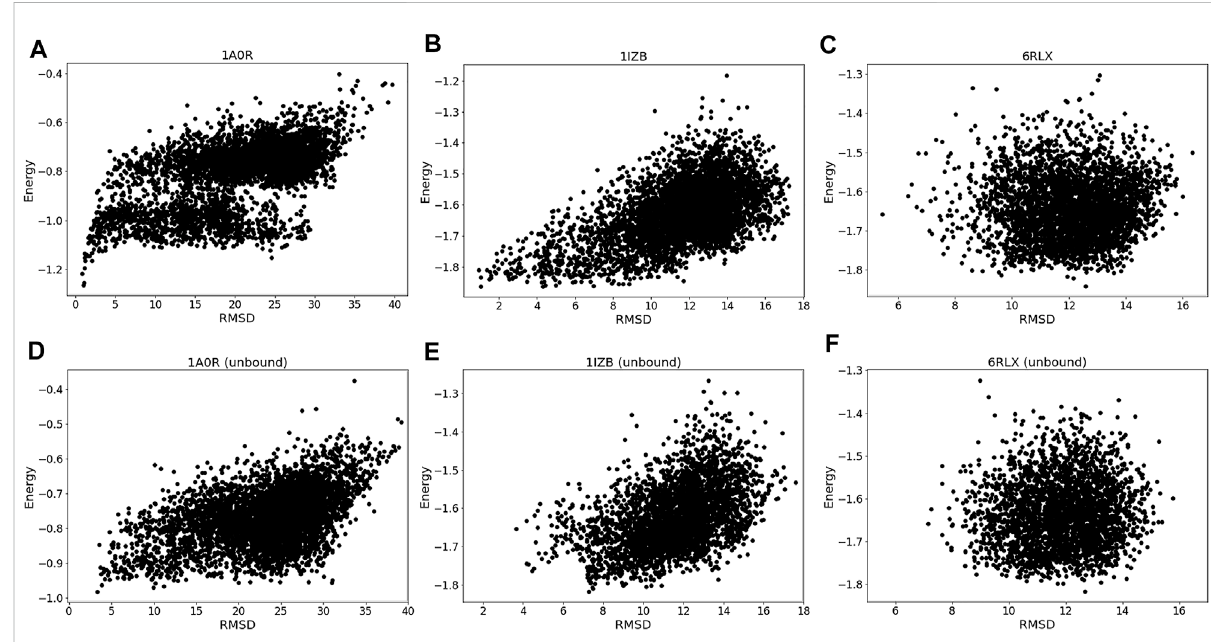
FIGURE 4 Energy distribution vs. RMSD. The x-axis shows the model RMSD while the y-axis is the model energy. All the models generated are plotted. Results for the same three targets used in Figure 3 were shown. (A) , 1A0R (bound case); (B) , 1IZB (bound); (C) , 6RLX (bound); (D) , 1A0R (unbound case); (E) , 1IZB (unbound); (F) , 6RLX